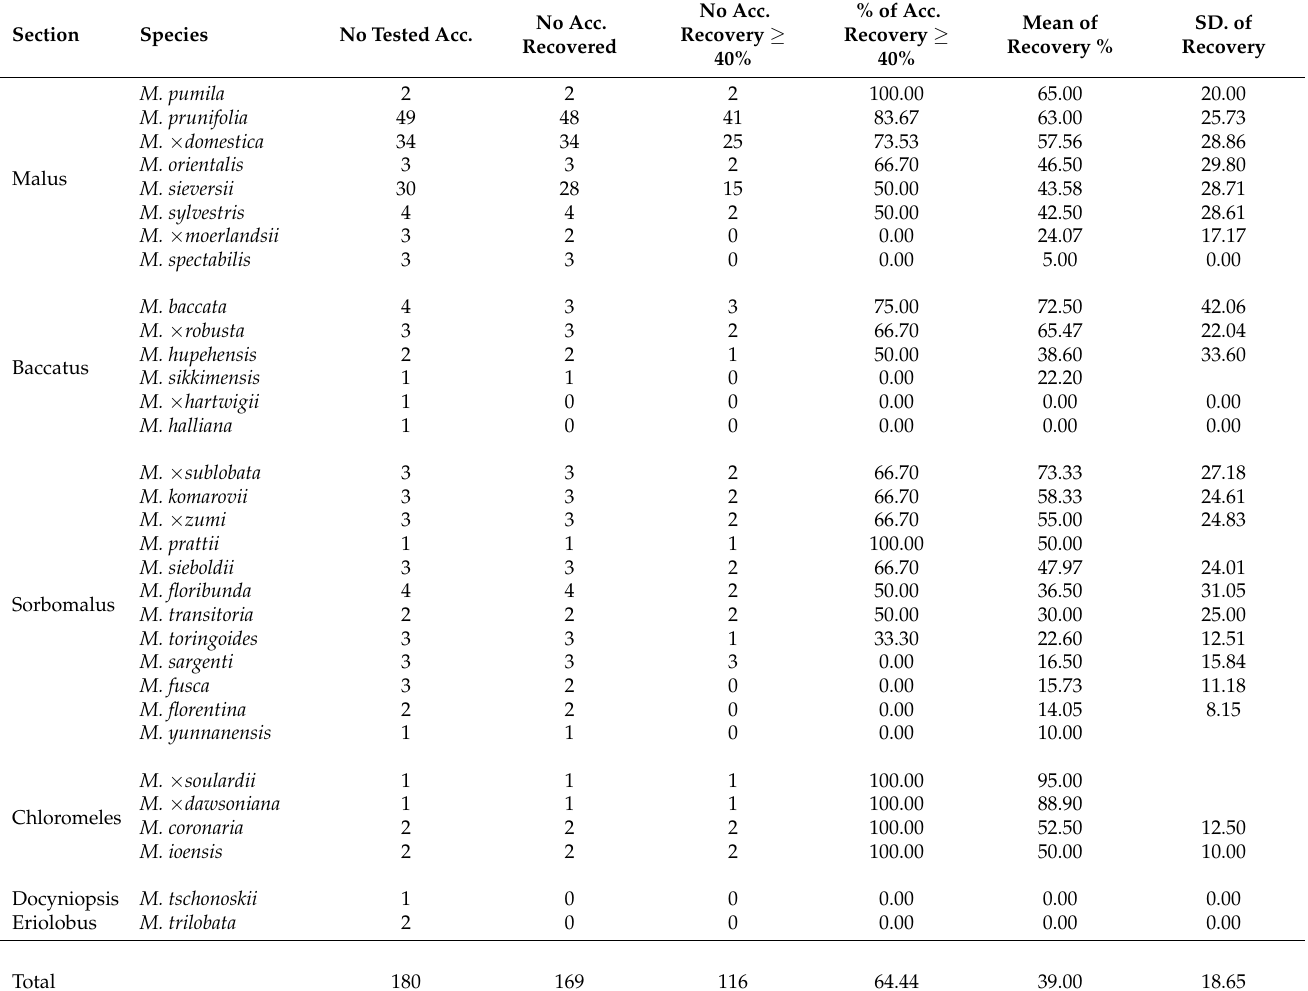
Table 1. Mean recovery rates after cryopreservation (%) of dormant bud explants is dependent on the Malus species. Rootstock for chip budding was M9. The taxonomic classification is according to Forsline et al.